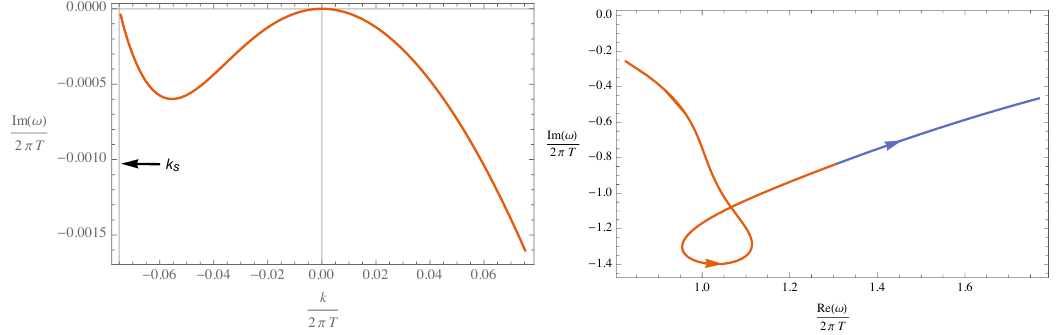
Figure 7 . Left: lowest purely imaginary quasinormal mode as a function of momentum. Right: complex frequency plane for the second quasinormal mode parametrized by the momentum, blue and red lines correspond to positive and negative momentum respectively. The arrows indicate the direction the momentum grows or decreases. The singular momentum is k s = (2 (cid:25)T ) = (cid:0) 0 : 075. The parameters are (cid:12)xed as (cid:22) = 1, (cid:21) = 1, (cid:11) = 0 and r + =